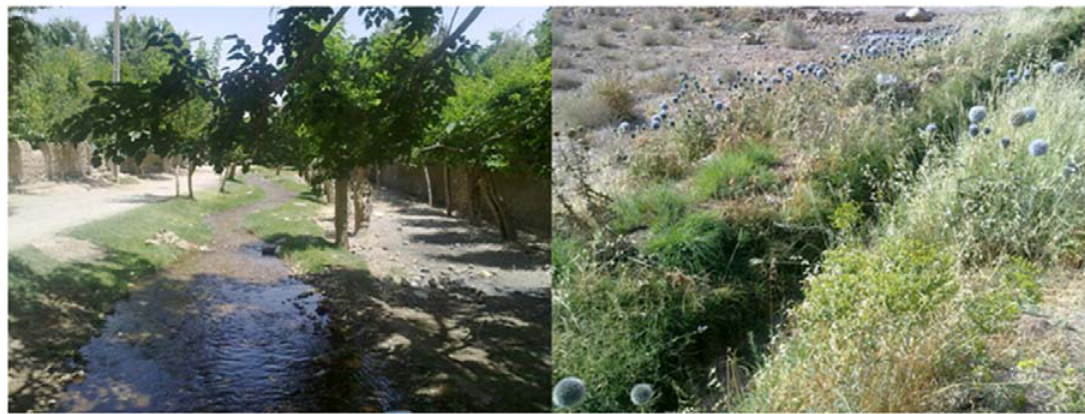
Figure 7. Two different types of Kariz